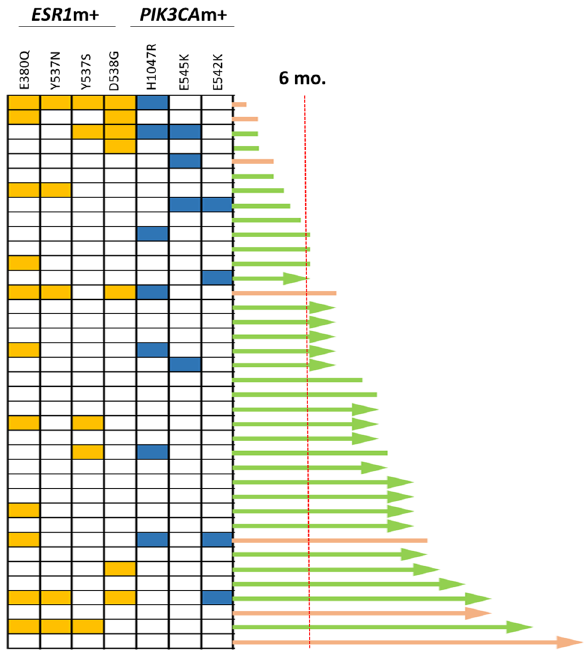
Figure 4. ESR1 and PIK3CA mutation profiles and responses to endocrine therapy with CDK4/6 inhibitors as the first line in 38 patients. Pink line, fulvestrant + CDK4/6 inhibitor; green line, letrozole + CDK4/6 inhibitor; arrow end, ongoing treatment; blunt end, stop due to disease progression; red dotted line, 6 months after the start of treatment; yellow box, ESR1 mutation; blue box, PIK3CA